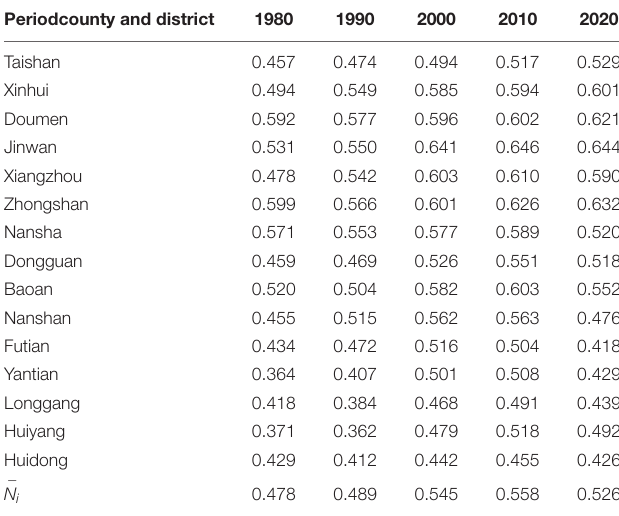
TABLE 2 | Evaluation results for coastal erosion vulnerability in each county, district and study area in each period. Periodcounty and